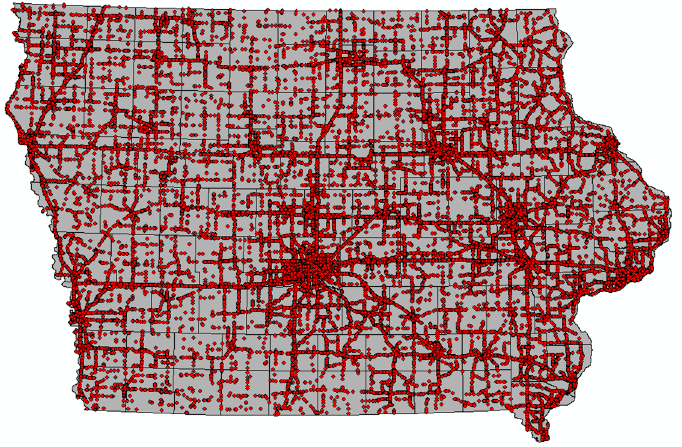
Figure 7. Reported collisions on the road network. Table 2. Seasonal collision statistics.